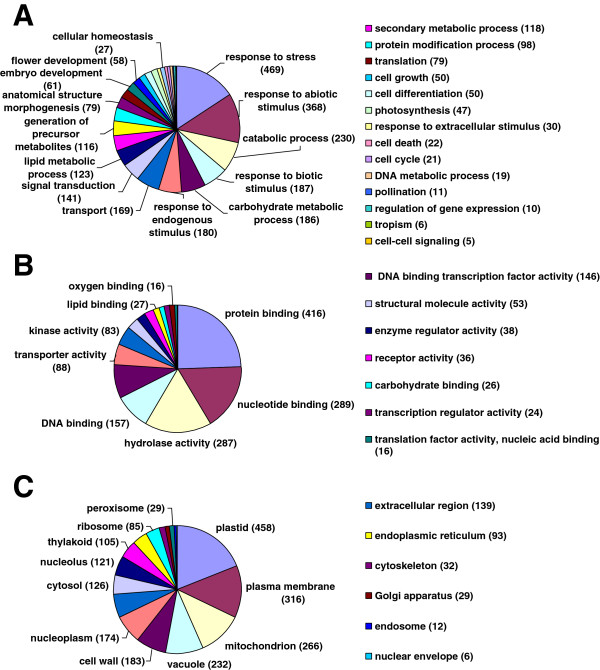
Functional categorization of GO terms in DEGs with RPKM ≥ 50 and fold change ≥ 2 by blast2GO. The genes are categorized based on Gene Ontology (GO) annotation and the proportion of each category is displayed based on: Biological process (A); Molecular function (B); Cellular component (C).